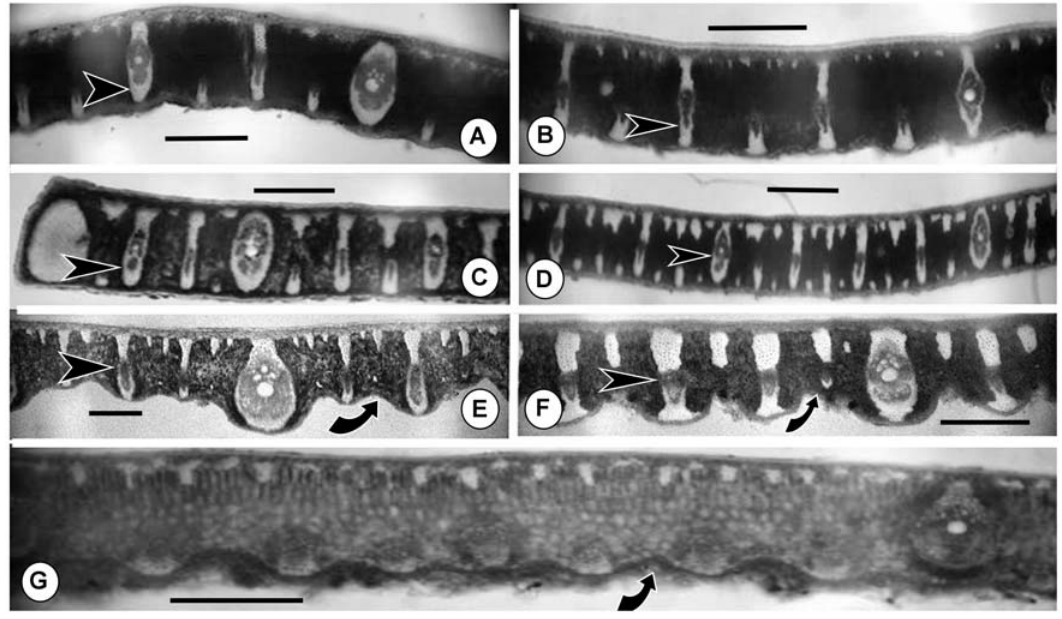
Figure 4. Freehand, unstained transverse sections of leaflets of Allagoptera , Parajubaea and Polyandrococos . A. Allagopetra arenaria . B. A. brevicalyx . C. A. campestris . D. A. leucocalyx . E. Parajubaea cocoides . F. P. torallyi . G. Polyandrococos caudescens . Black arrows with white outlines (A–F) point to ‘‘girder’’-like vascular bundles in Allagoptera and Parajubaea . Curved arrows indicate depressions in abaxial surface (E–G) characteristic of Parajubaea and Polyandrococos . Scale bars=ca. 0.5